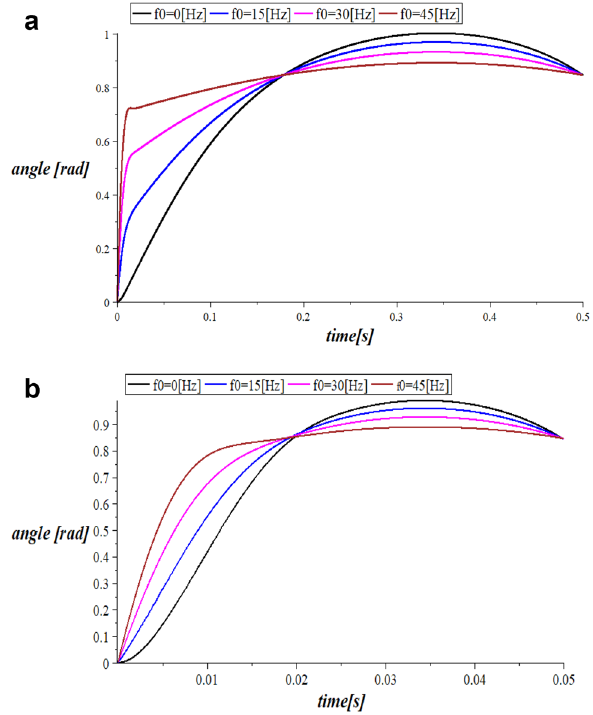
Fig. 20 Results of solution of the equation φ = ( 𝜔 t − 𝜌 ) for the sine-shaped voltage frequency f v 2 ( t ) increase from f 50 (Hz) . The period of increase is: 0,10,20,30,40 (Hz) to f k = 0 = T = 0.6 (s) or a , and T = 0.05 (s) for